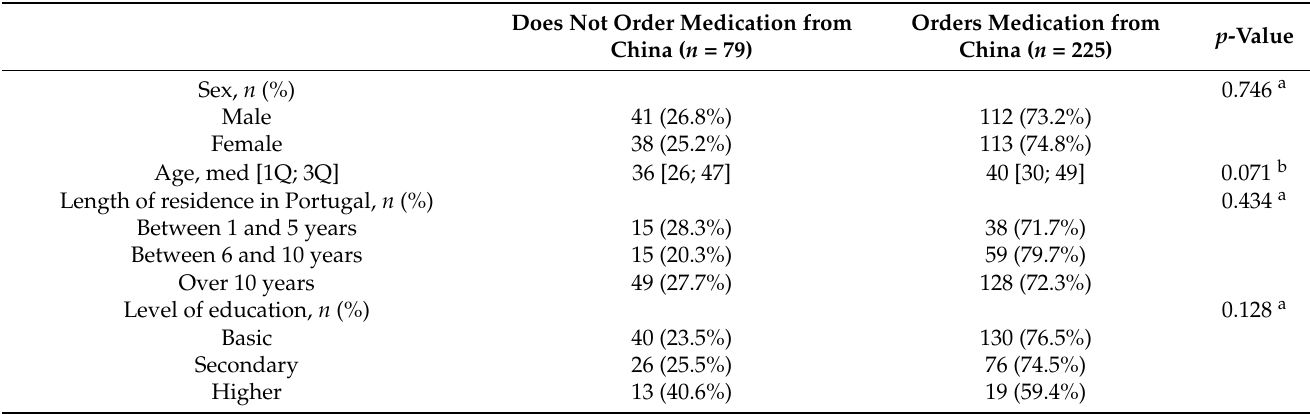
Table 7. Comparison of the variables sex, age, length of residence in Portugal and level of education according to the ordering of medications from China ( n =